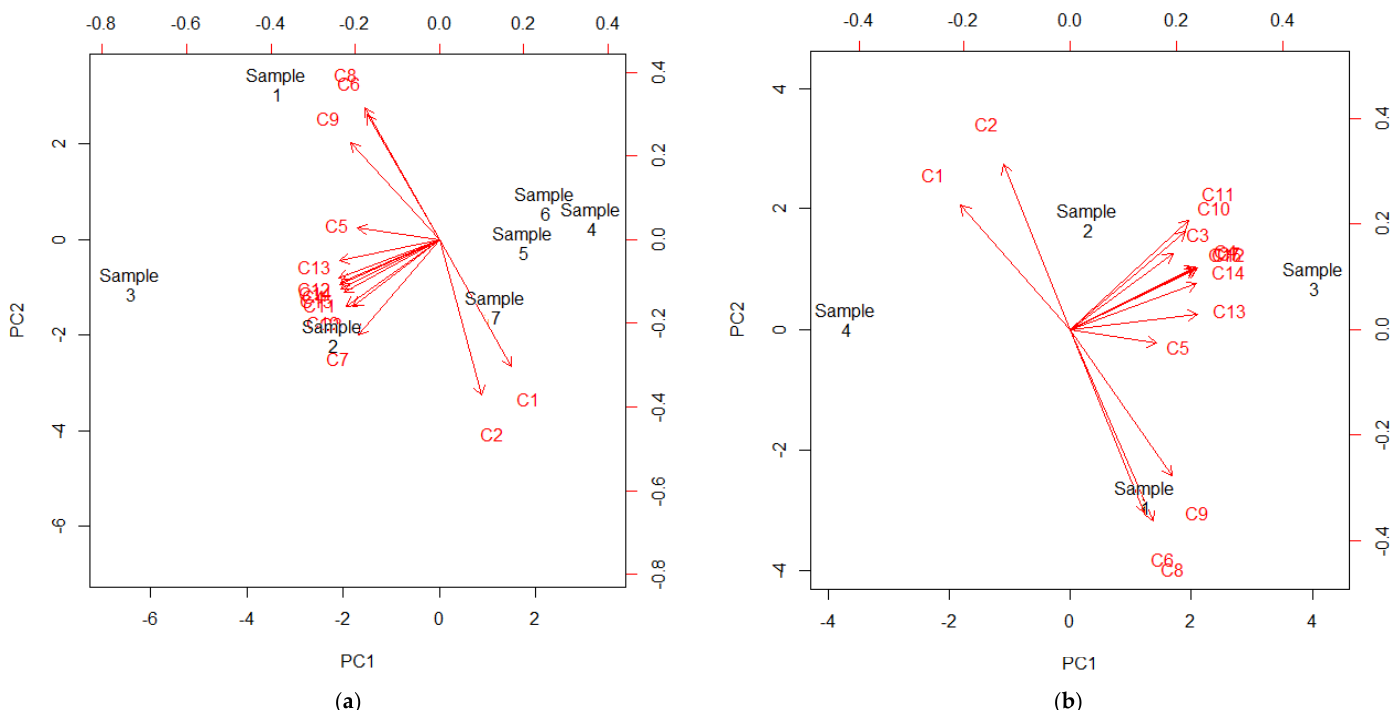
Figure 2. Phenolic content PCA of: ( a ) all samples, and ( b ) samples collected in December 2014.